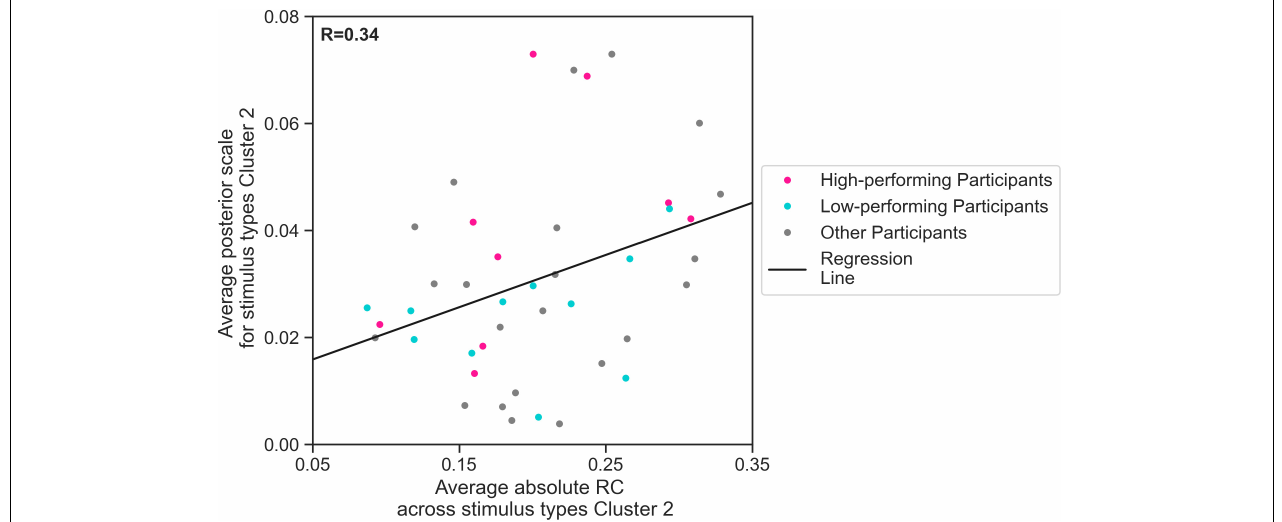
FIGURE 6 | The relationship between zero % coherence response consistency and average posterior estimates of the EXaM’s scale parameter. The average posterior scale estimate for Cluster 2 stimulus types ( sc 2 ) is plotted as a function of average absolute RC across Cluster 2 stimulus types. The regression line shows a positive correlation between two variables (linear regression Eq. 2, R = 0.34, p < 0.05 ). The data from two participants was excluded as their sc 2 values were outliers.